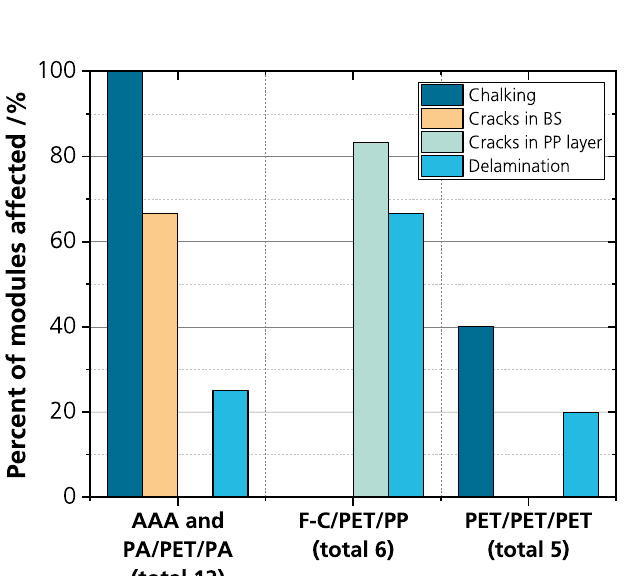
Fig. 2. Distribution of the failures in the most relevant degraded backsheet structures after several years of